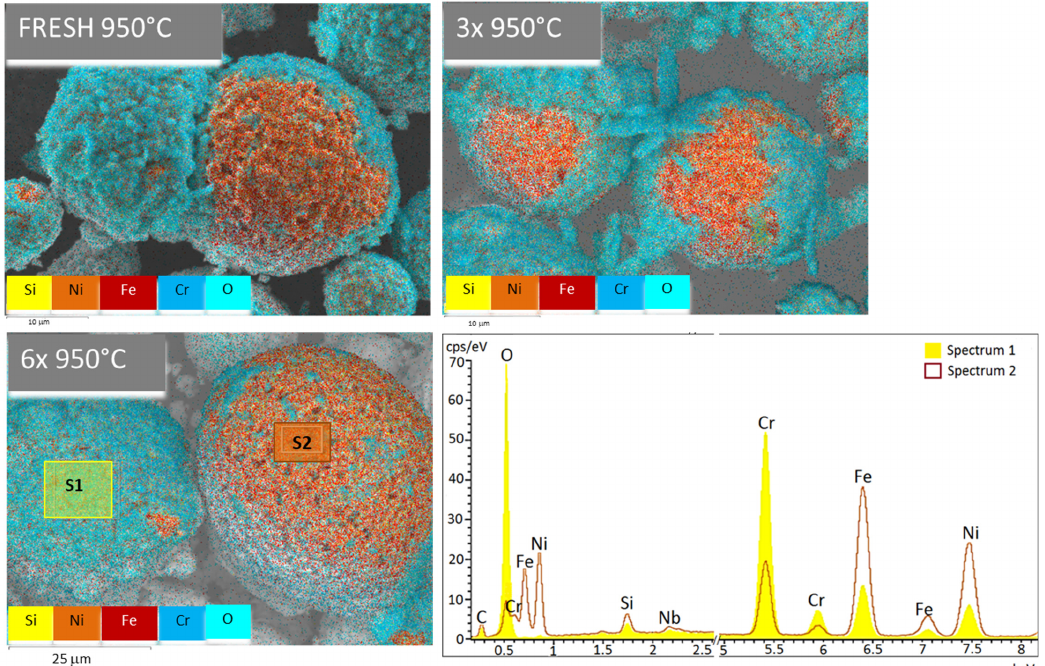
Figure 4. Mapping of particle surfaces along with spectrum evaluation of main elements for sam- ple 6 × . From the mapping of the two areas of interest—the shell (S1) and the core (S2)—and from the interpolation of both spectra, a significant effect of the temperature treatment is evident. The basic core material is FeNi alloy, and the shell is made of CrO